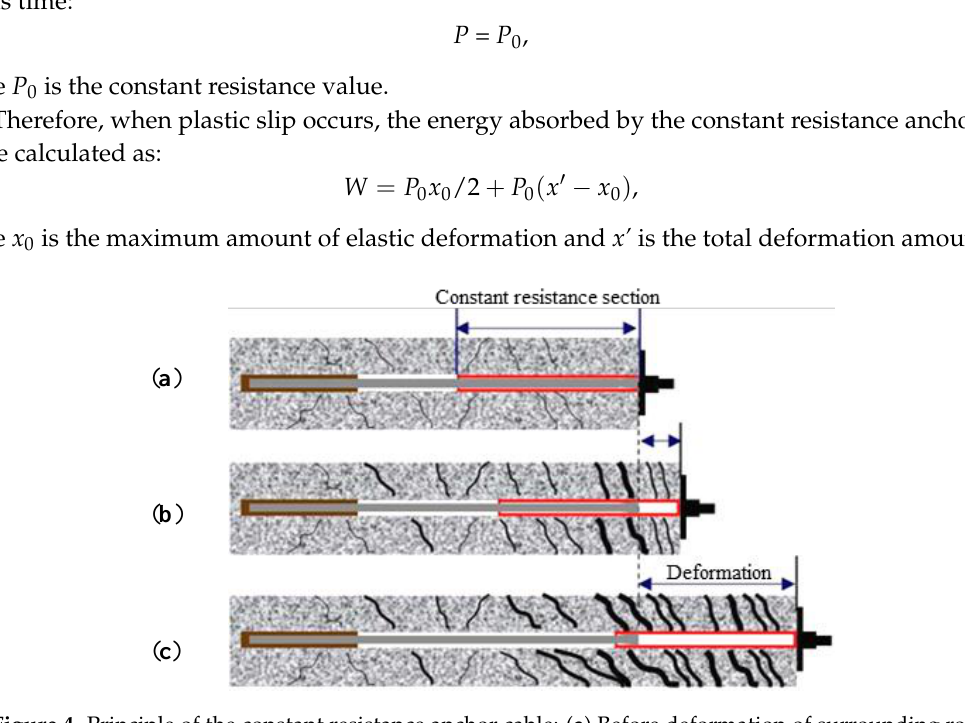
Figure 5 . Constitutive and energy models for the constant resistance anchor cable: ( a ) Constitutive relation; ( b ) Energy model.